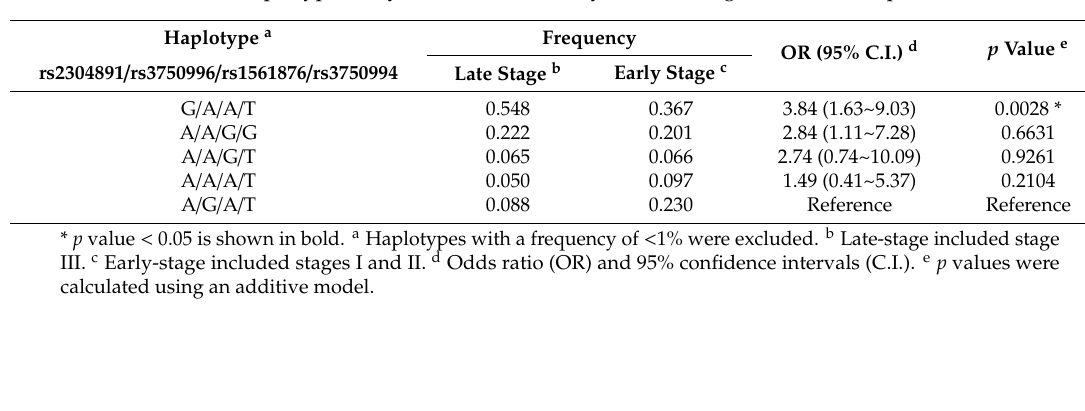
Table 5. Haplotype analysis of STIM1 in early and late-stage breast cancer